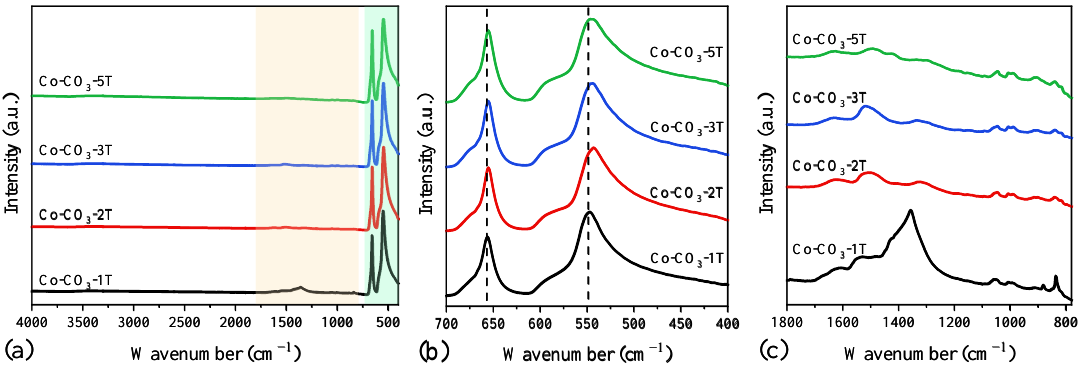
Figure 4. ( a ) Full and ( b , c ) partial FT-IR spectra of the catalysts.